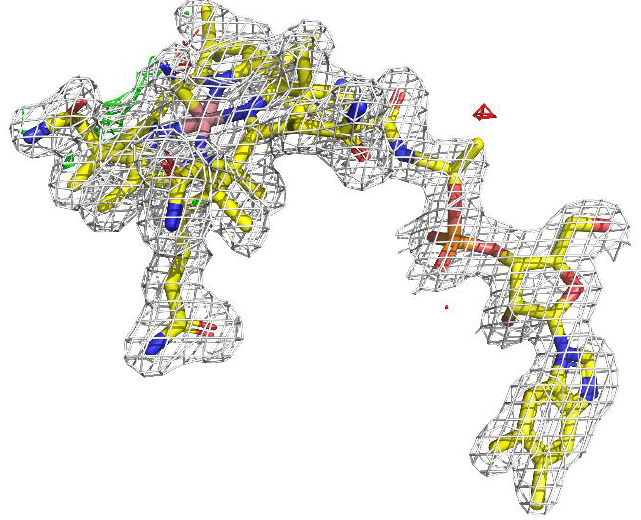
Figure 4. The electron density maps of CNCbl. 2 F o – F c (white) electron density maps were contoured at 1 σ. F o – F c (red and green) electron density maps were contoured at −3σ and 3σ, respectively.